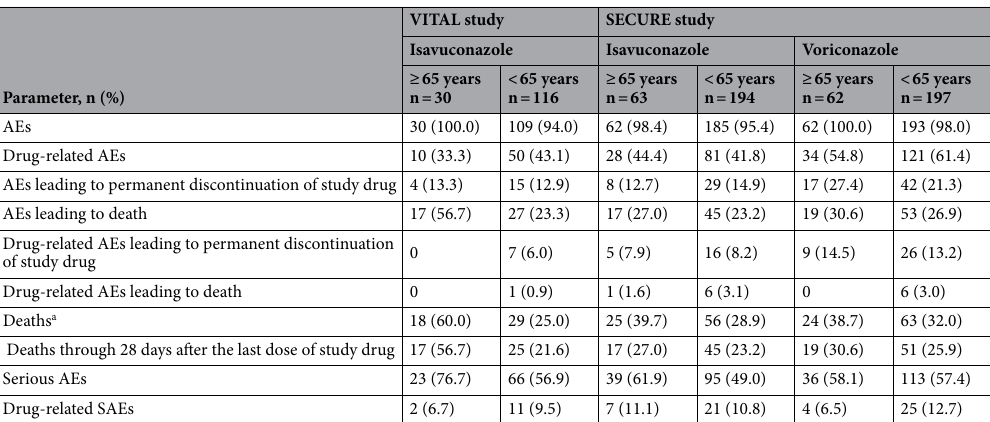
Table 3. Overview of treatment-emergent adverse events and death (safety population). Treatment-emergent AE is an AE starting after first study drug administration until 28 days after the last dose of study drug. Study drug-related AEs include those reported as remotely, possibly, or probably related to the study medication by the investigator and those with a missing relationship. An AE with a missing seriousness assessment was considered as serious. AEs adverse events, SAEs serious adverse events. a All reported deaths after first dose of study drug are summarized, regardless of the number of study days after the last dose of study